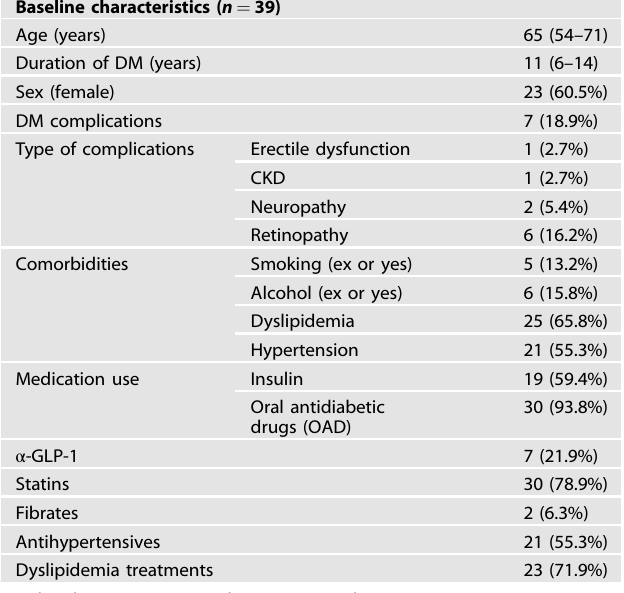
Table 1. Baseline characteristics of patients ( n =